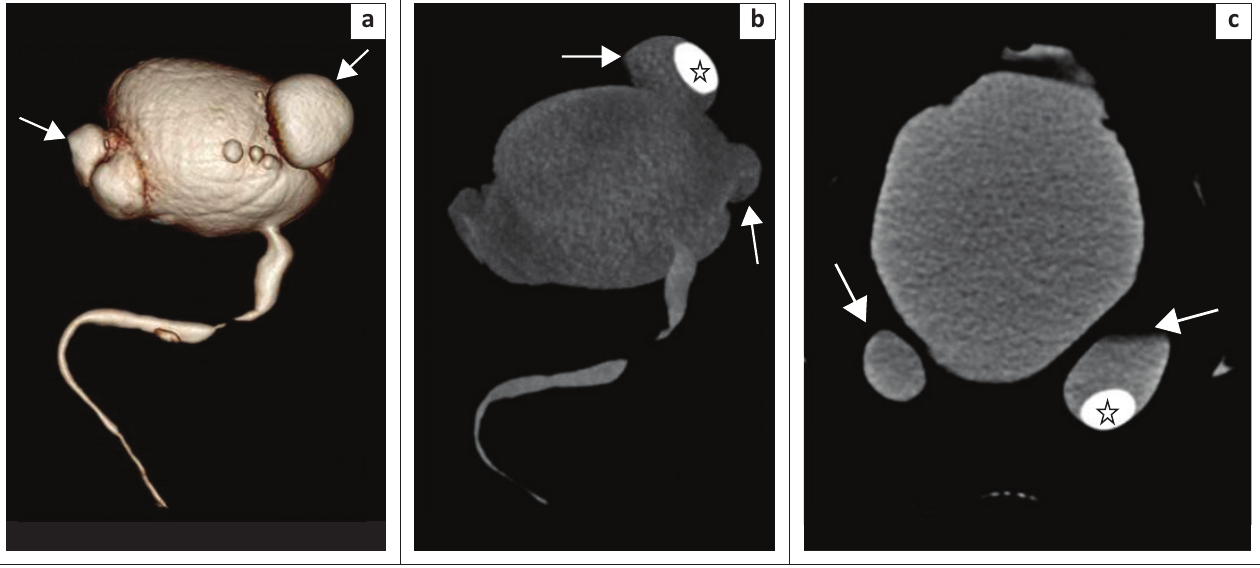
FIG URE 13: (a) Volume rendered technique, (b) maximum intensity projection and (c) axial multiplanar reformatted (MPR) images of multidetector computed tomographic urethrography. All the images are of the same patient, showing multiple bladder diverticula (arrows). A calculus (asterisks) is noted within the diverticulum on coronal and axial MPR